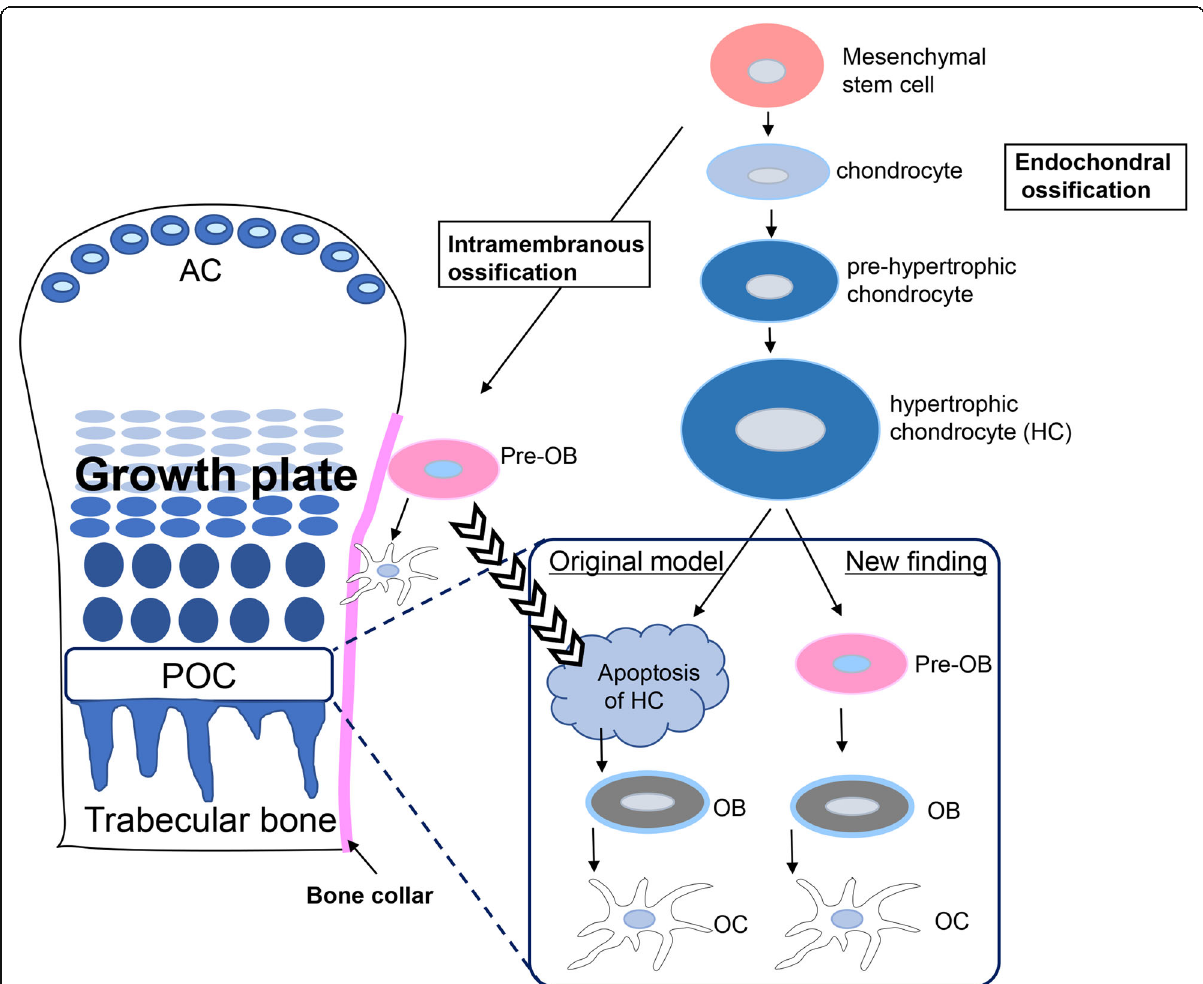
Fig. 1 Fate of hypertrophic chondrocytes in the growth plate. In the primary ossification center, POC, hypertrophic chondrocytes enter apoptosis; it was the original theory for endochondral ossification in the growth plate. Recent data on the fate of hypertrophic chondrocytes in the growth plate are controversial because hypertrophic chondrocytes directly differentiate into osteoblasts in the POC. AC, articular chondrocyte: OB, osteoblast; OC,